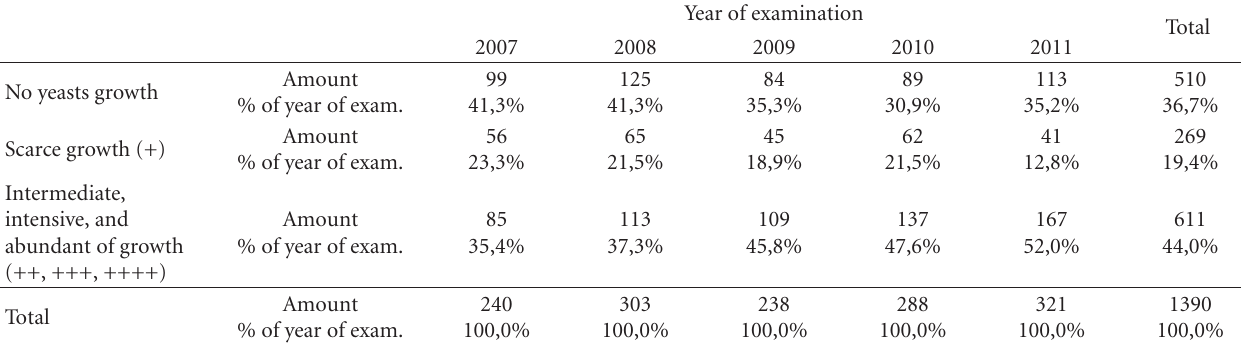
Table 8: Distribution of yeasts growth according to the year of examination.